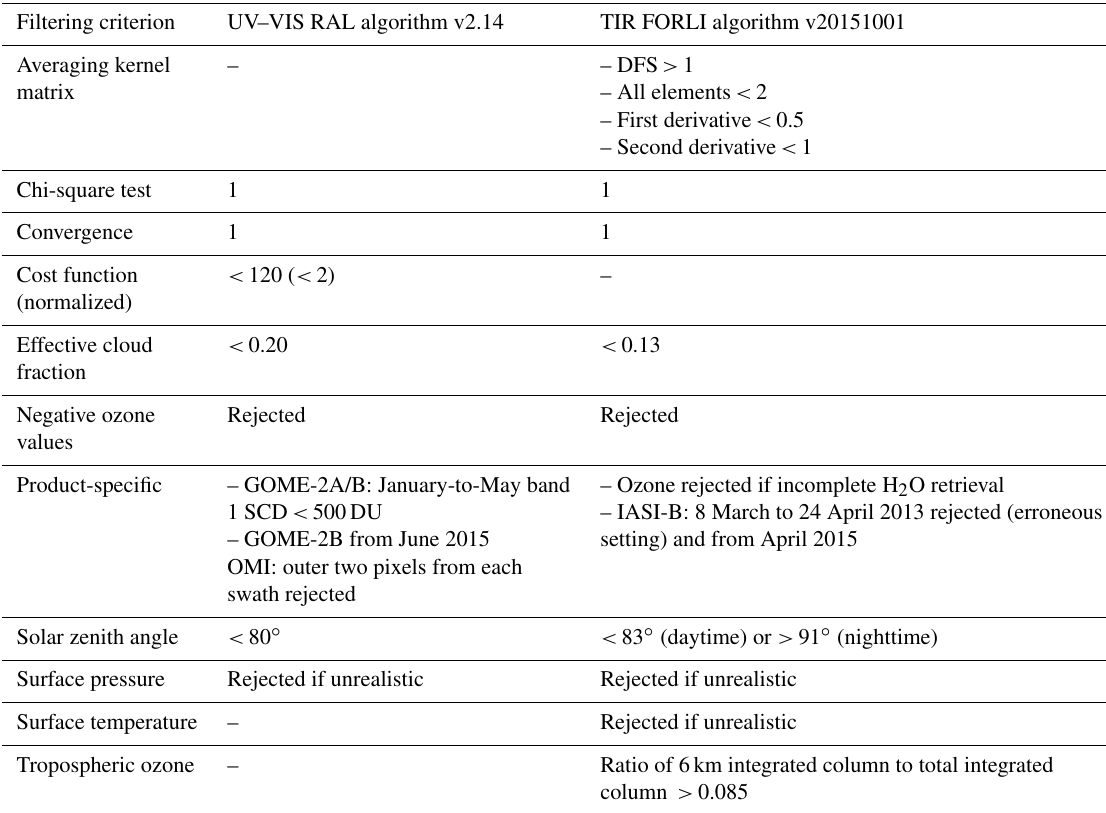
Table 3. L2 nadir ozone profile filtering criteria applied in this work (first column) and their settings for the RAL UV–VIS retrieval algorithm (second column) and the FORLI TIR retrieval algorithm (third column). Values that do not comply with the settings are rejected as suggested by the respective data